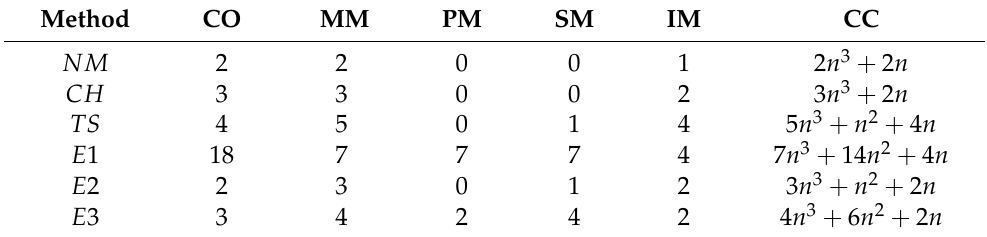
Table 2 lists the convergence order (CO), the number of operations for Q n × n R n × n